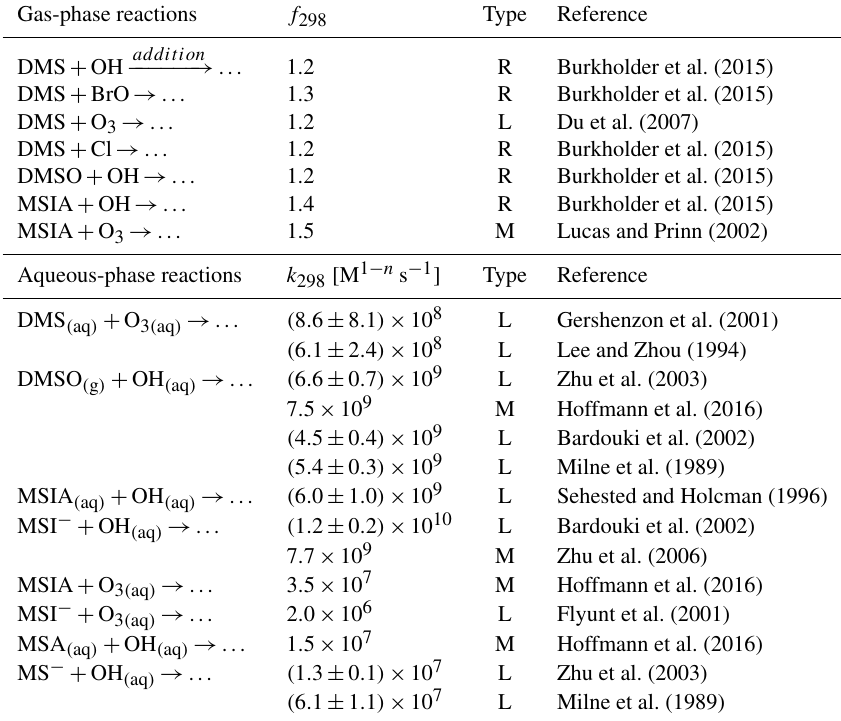
Table 4. The uncertainties of the rate constants for the 12 reactions added in the model. The uncertainty factor f 298 means the reaction rate constant may be greater than or less than the recommended value by the factor f 298 . Type “R”, “L” and “M” represent values obtained from “literature reviews”, “laboratory measurements” and “modeling studies”,